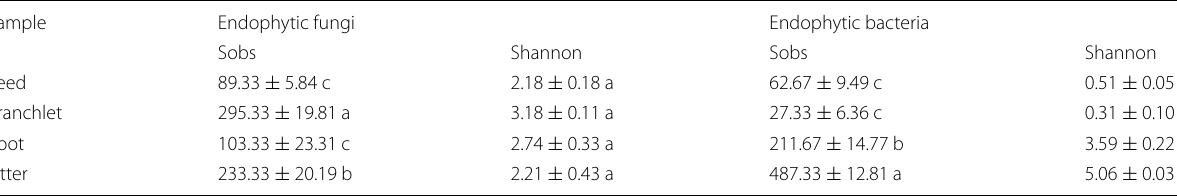
Sobs index represents species richness Shannon index represents species diversity Different letters indicate significant differences ( P < 0.05)